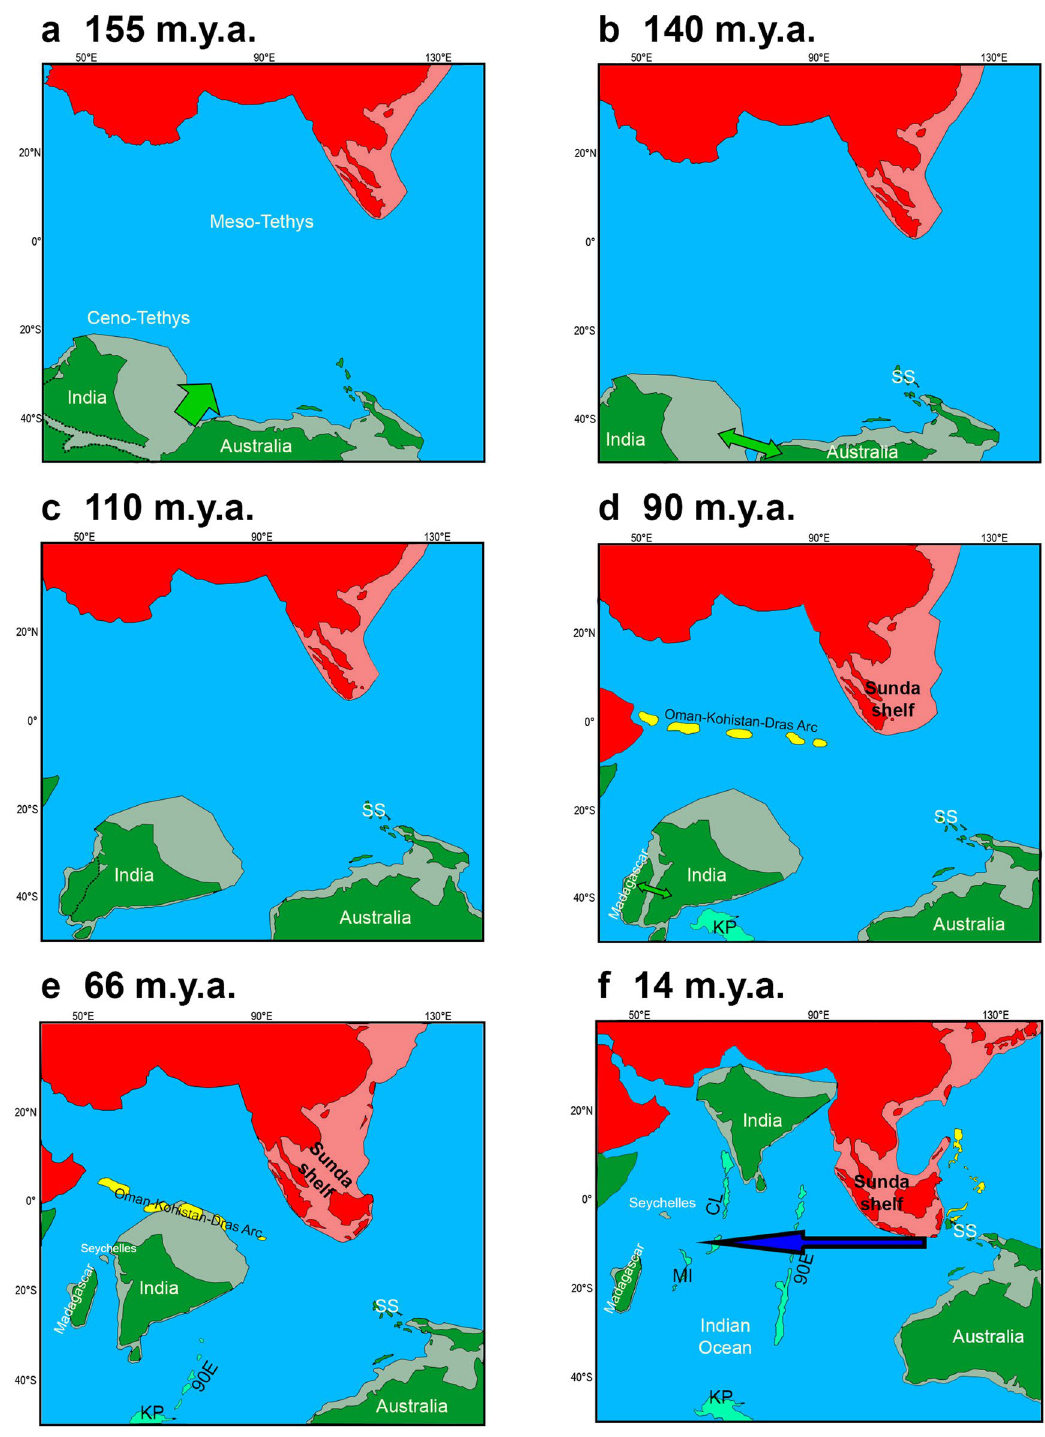
Figure 1. Geologic reconstruction of the Indian Ocean’s continents through the Mesozoic and part of the Cenozoic at 155 Ma ( a ), 140 ( b ), 110 ( c ), 90 Ma ( d ), 66 Ma ( e ), and 14 Ma ( f ). Laurasian landmasses are represented in red and Gondwanan landmasses in green. Areas in yellow are volcanic islands and in cyan are volcanic ridges (90E: Ninetyeast Ridge; CL: Chagos-Laccadive Ridge; MI: Mascarene Islands) and plateaus (KP: Kerguelen Plateau). The lightly coloured areas next to the continents represent continental shelves, which may or may not have been emergent depending on the timeframe. Dashed lines represent boundaries of continental break-ups; green arrows represent major break-up events; and the blue arrow represents the MIOJet. SS: Sula Spur. Redrawn from refs. 1,5,8